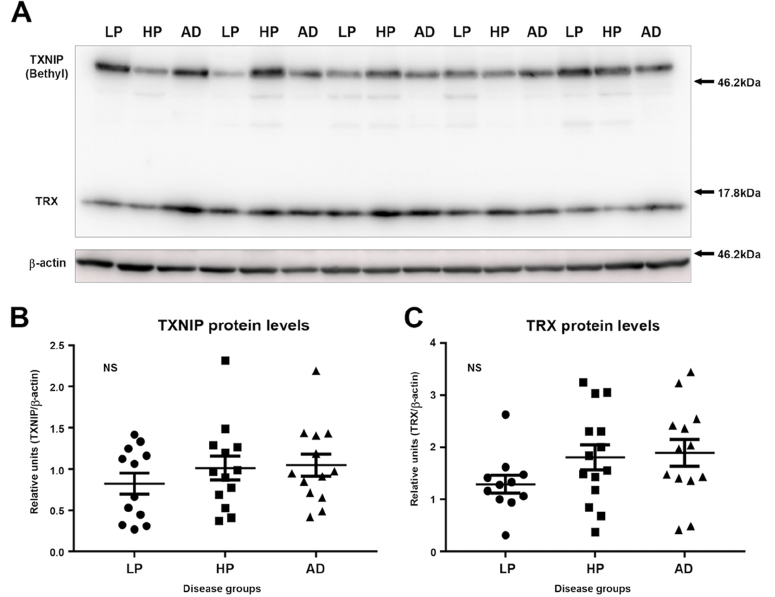
Figure 3. TXNIP and TRX levels in low-plaque (LP), high-plaque (HP), and Alzheimer’s disease (AD) cases. ( A ) Repre- sentatives immunoblot of LP, HP, and AD cases showing TXNIP and TRX bands simultaneously on the same membrane. Membranes were probed with rabbit anti-TXNIP (Bethyl, 1:10,000 dilution) and rabbit anti-TRX (Abcam, 1:5000 dilution). Membranes were subsequently reacted with HRP-labeled anti- β -actin antibody (1:15,000) for normalization of loading. ( B ) Relative levels of TXNIP in LP, HP, and AD middle temporal gyrus brain protein extracts. Relative intensities were normalized for β -actin levels. NS, non-significant differences between groups. ( C ) Relative levels of TRX detected in LP, HP, and AD middle temporal gyrus brain protein extracts. Relative intensities were normalized for β -actin levels. NS, non-significant difference between groups.